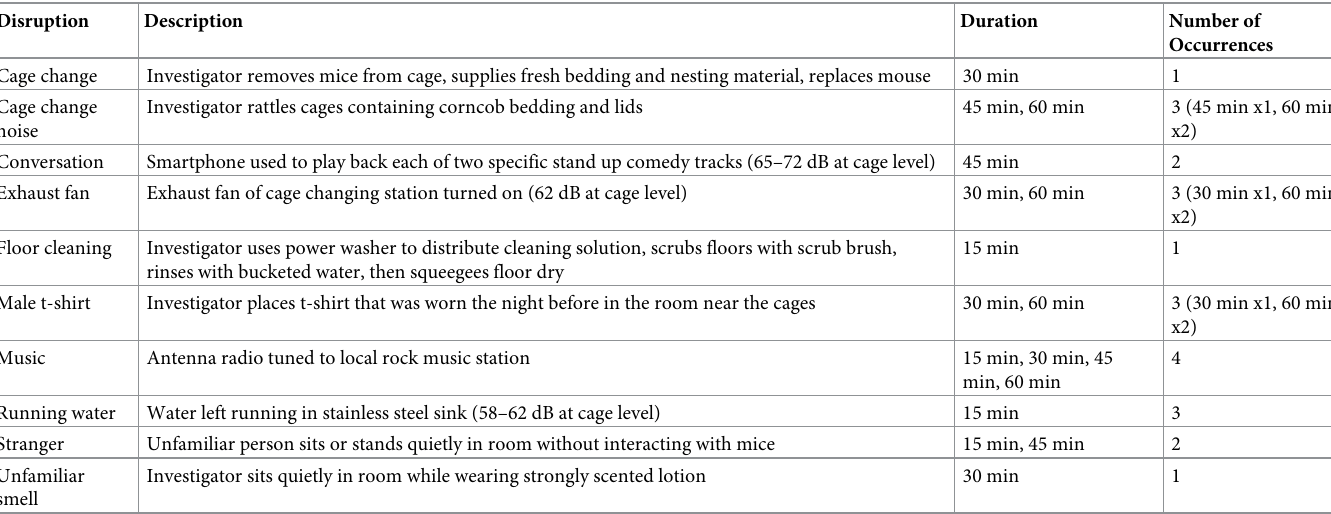
Table 2. Sleep disruptions and